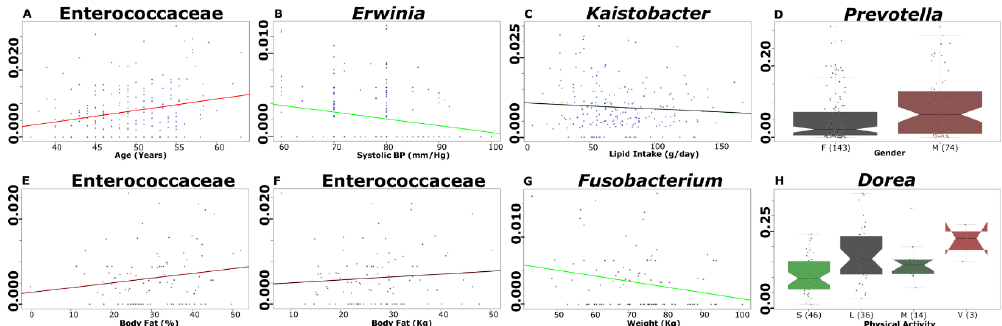
Figure 5. Multivariate association of the gut microbiota with all measured variables using MaAsLin.